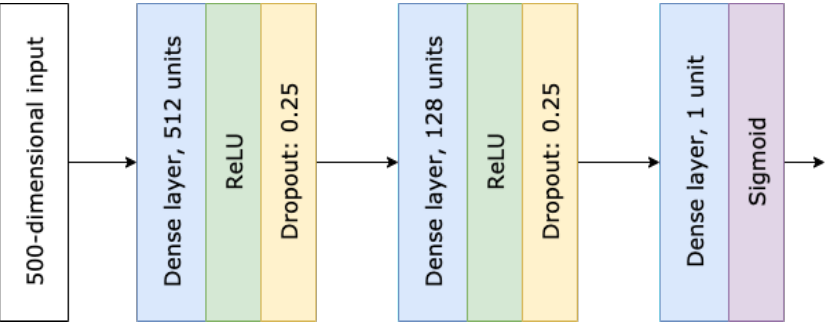
Figure 12. Neural network architecture used for teachers and student in Web Request